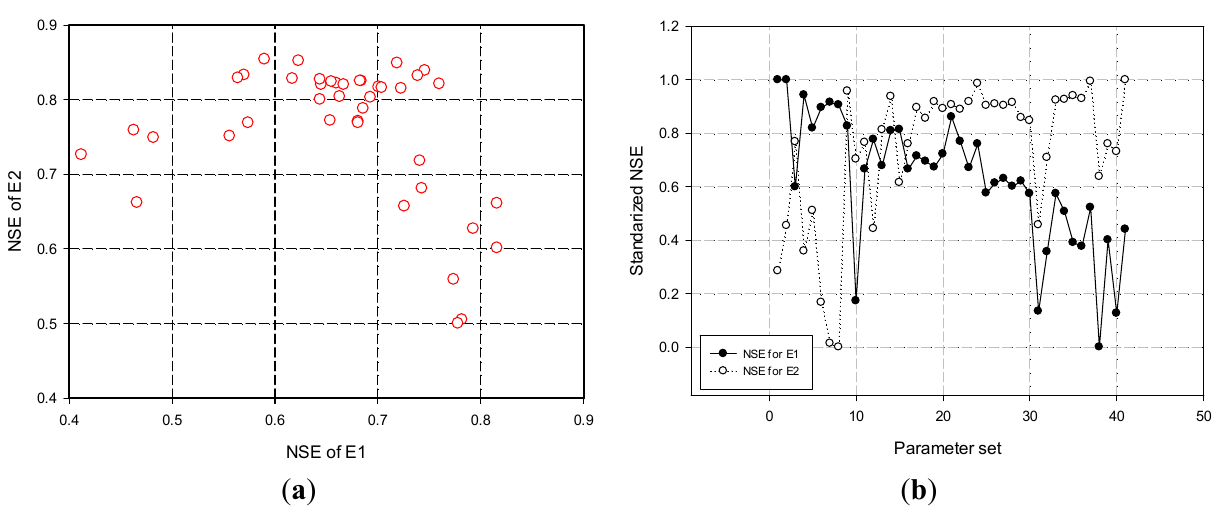
Figure 4. NSEs for E1 and E2 with 41 parameter sets: ( a ) scatter plot between two NSEs ( i.e. , Pareto optimal sets) and ( b ) standardized NSEs along the 41 parameter